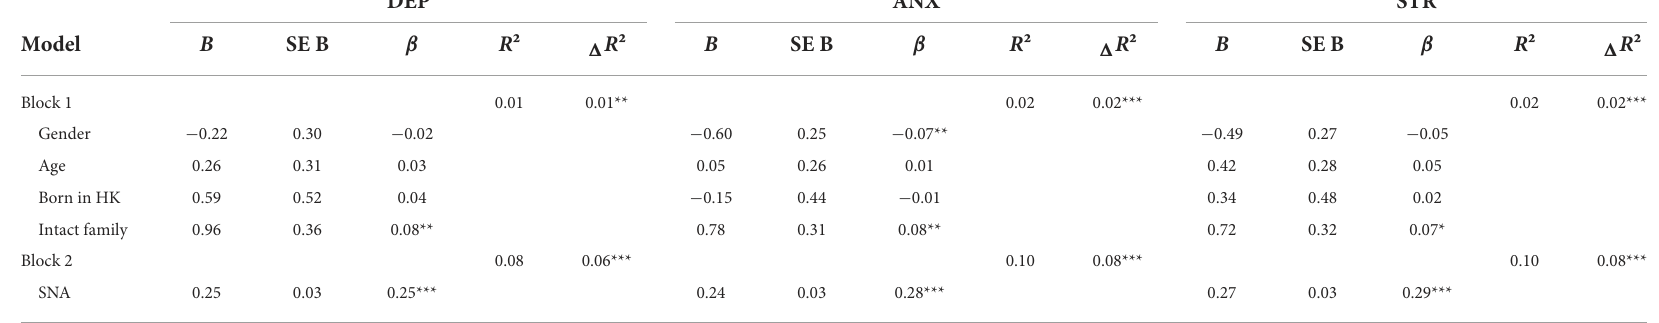
TABLE 4 Results of multiple regressions on the predictive effects of SNA on the participants’ mental health indicators.